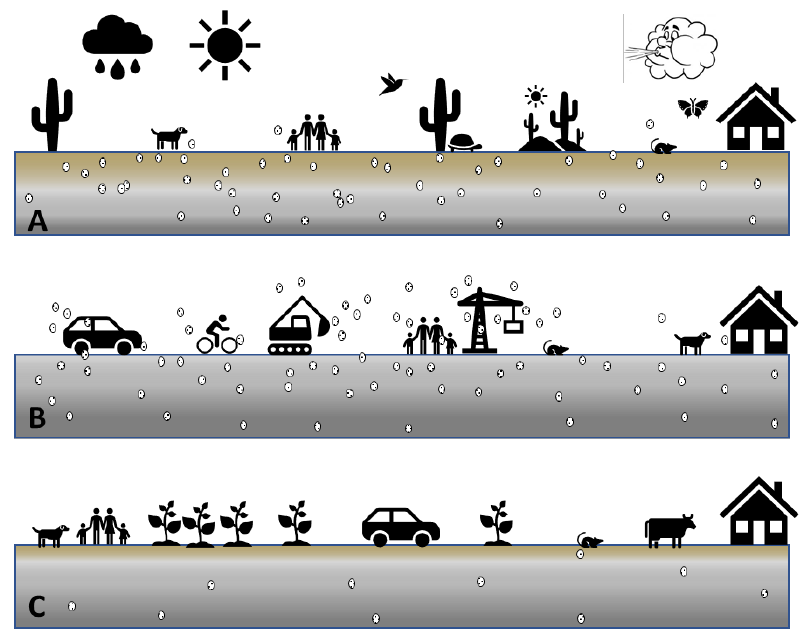
Figure 11. Conceptual model of environmental exposure pathways for Valley fever. ( A ) Undisturbed natural landscape with intact soil and diverse vegetation, including native species. Coccidioides growth supported, but few arthroconidia airborne (indicated as white, small, oval-shaped objects with black dots). ( B ) Freshly disturbed natural landscape with reduced or no vegetation. Coccidioides growth supported with increased airborne arthroconidia. Vehicle traffic, off-road biking, construction, as well as oil drilling are factors that highly erode soils. ( C ) Aged disturbed landscape with reduced or altered vegetation, such as agricultural fields under management, orchards with suppressed vegetation between trees, or dairy farms with high manure contamination of the soil. Coccidioides growth is inhibited and few arthroconidia become airborne.